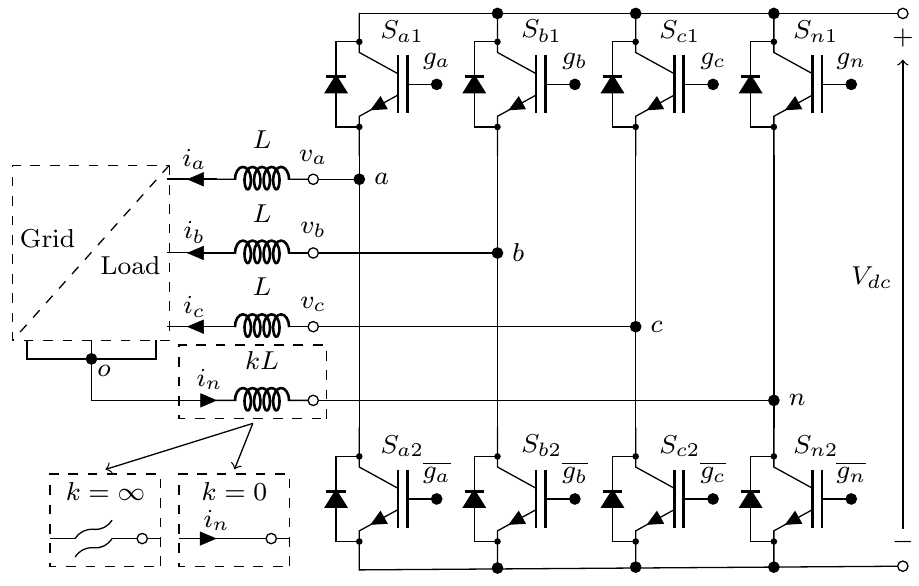
Figure 1. General circuit scheme of a three-phase, four-leg voltage-source converter with a neutral line inductor.